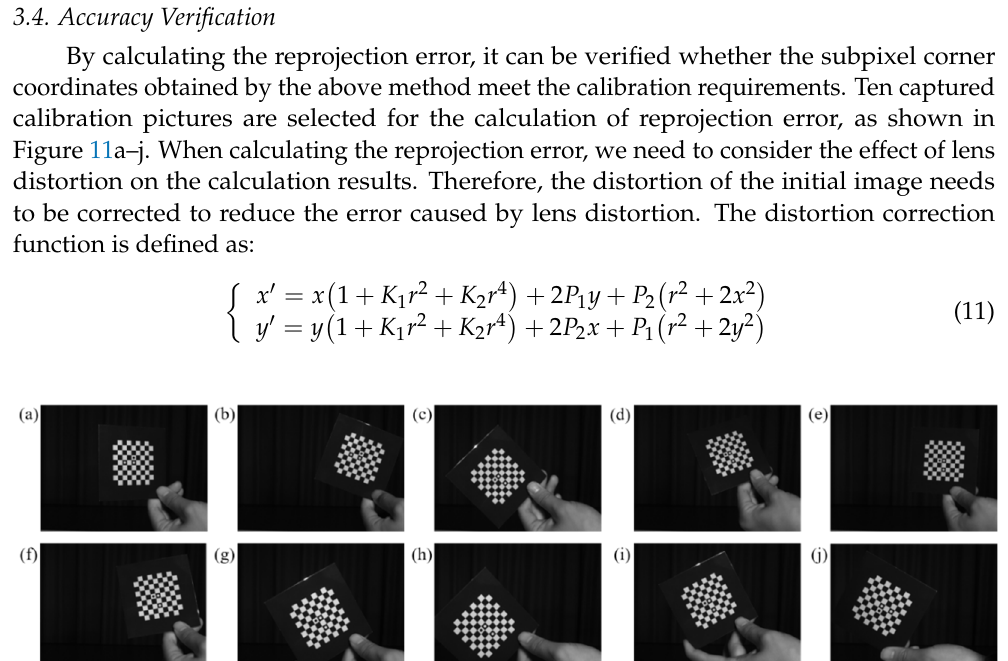
Figure 10. The flow chart comparison between our algorithm and MATLAB toolbox.